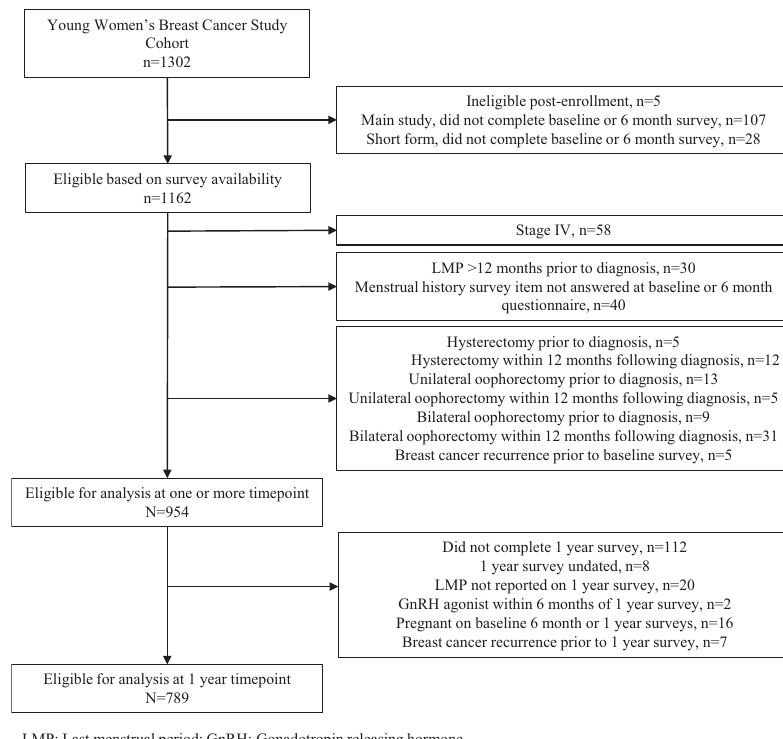
Fig. 2 Participant fl ow diagram. 789 eligible participants were evaluable at the 1-year